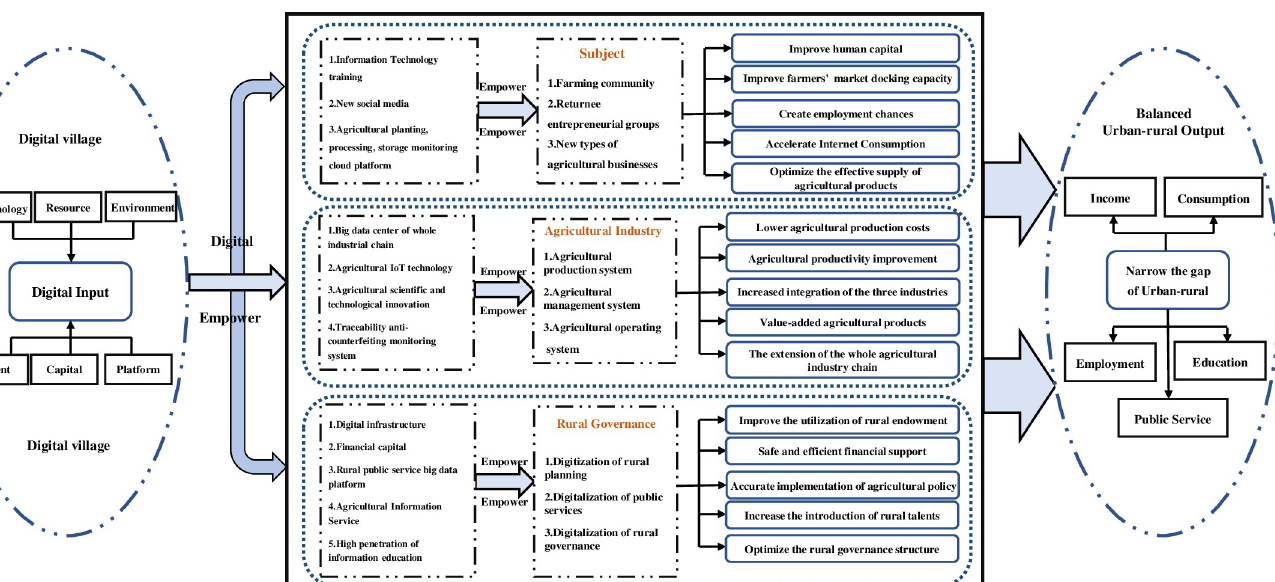
PLOS ONE | https://doi.org/10.1371/journal.pone.0270952 August 1,